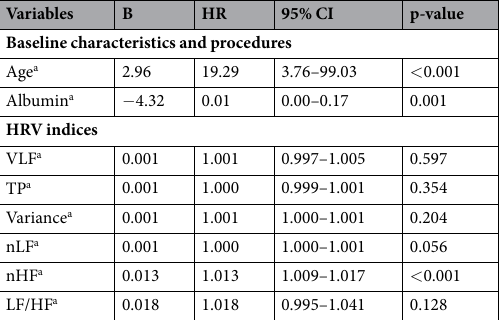
Table 4. Independent predictors for infection-associated mortality after an 8-year follow-up. Note: All HRV measurements had been adjusted by mixed models and subsequently put into a multivariate Cox regression method with adjustment to baseline characteristics and clinical variables. In the mixed model, VLF, TP, and nLF were adjusted by times (HRV-0, -1, -2, -3); Variance was adjusted by times (HRV-0, -1, -2, -3) and comorbidities with peripheral arterial disease; nHF was adjusted by times (HRV-0, -1, -2, -3) and age; LF/HF was adjusted by times (HRV-0, -1, -2, -3), age, and blood urea nitrogen. a Every increment of one unit. Units: Ln (ms 2 ) in VLF, TP, and variance; Ln (ratio) in LF/HF ratio; normalized units in nLF and nHF. Abbreviations: B, beta coefficient; CI, confidence interval; HR, hazard ratio; HRV, heart rate variability; Ln, nature logarithmical; nHF, normalized high-frequency; nLF, normalized low-frequency; TP, total power; Variance, the variance of the R-R intervals; VLF,